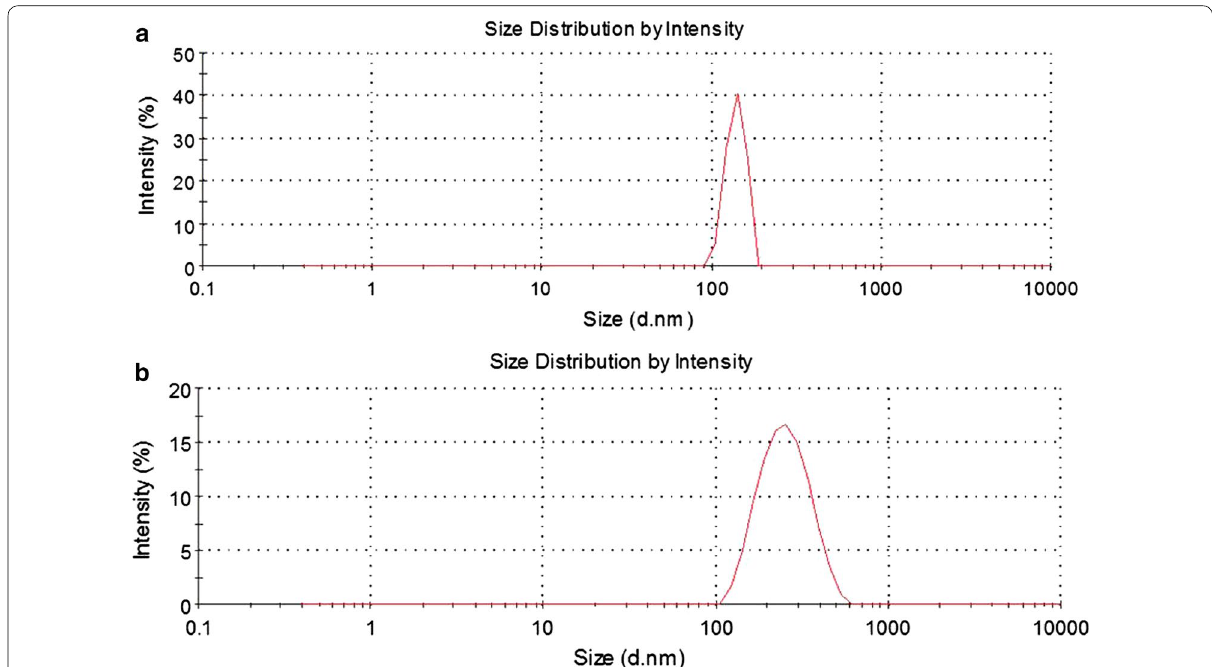
Fig. 5 Characteristics of liposomes and immunoliposomes. The mean particle sizes of liposomes and immunoliposomes were measured by Malvern Zetasizer Nano ZS90 instrument (Malvern Instruments Ltd., UK). a Shows the size of liposomes, and b shows the size of immunoliposomes